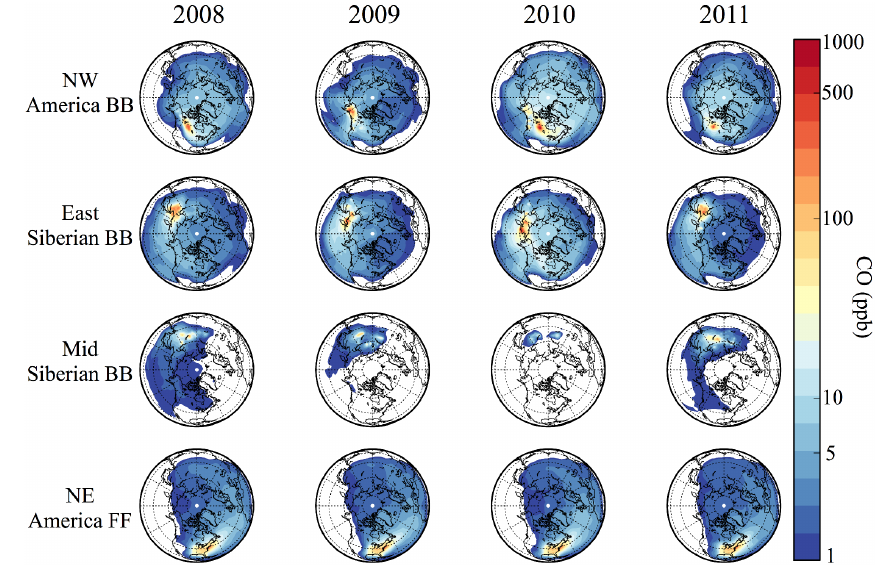
Figure 4. Mean June–August GEOS-Chem model surface CO concentrations (ppb) from the four largest sources over the Northern Hemi- sphere for 2008–2011. Individual contributions (Fig. 1) are from NW North America biomass burning emissions (first row), NE North America fossil fuel (second row), East Siberia biomass burning (third row), and mid-Siberia biomass burning (bottom row).